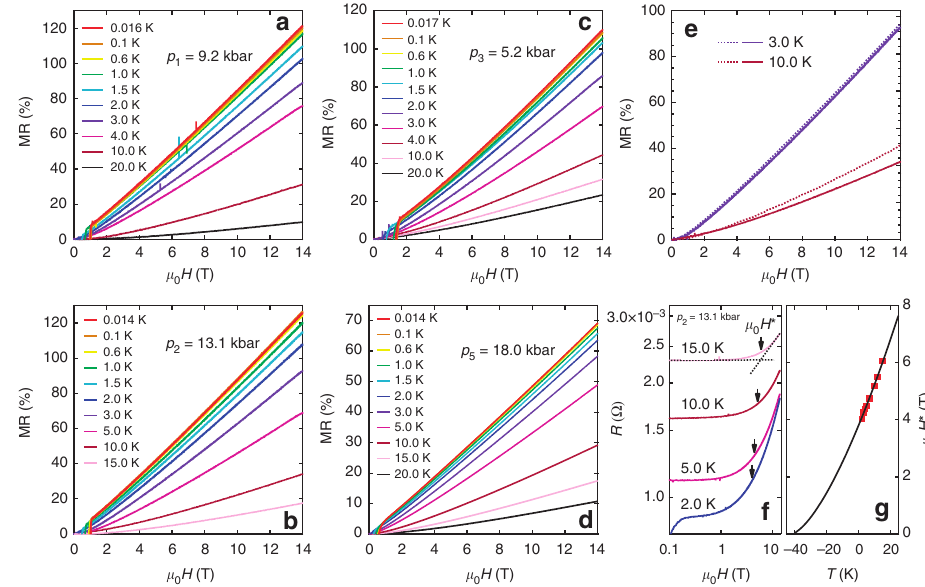
Figure 2 | Magnetoresistance of CrAs under pressure. ( a – d ) Magnetoresistance of CrAs over a wide temperature range at p 1 , p 2 , p 3 and p 5 . The spikes at some traces are experimental artefacts. ( e ) Magnetoresistance at p 2 (solid lines) and p 4 (dashed lines). The traces at p 4 are multiplied by 1.62, which is the ratio RRR( p 2 )/RRR( p 4 ). ( f ) The field dependence of the resistance at p 2 on logarithmic scales, showing the determination of the crossing over field m 0 H *. ( g ) The temperature dependence of m 0 H * (squares) at p 2 , which can be described by m 0 H * ¼ a ( T þ b ) 3/2 (solid line).